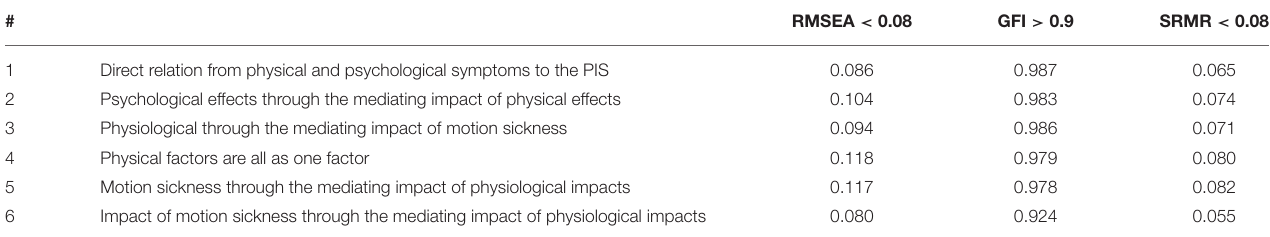
TABLE 2 | Comparison across some of the considered